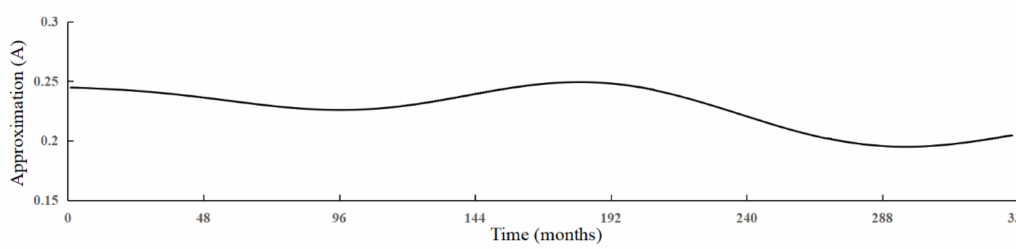
Figure 7. Trend term of the rainfall original series.